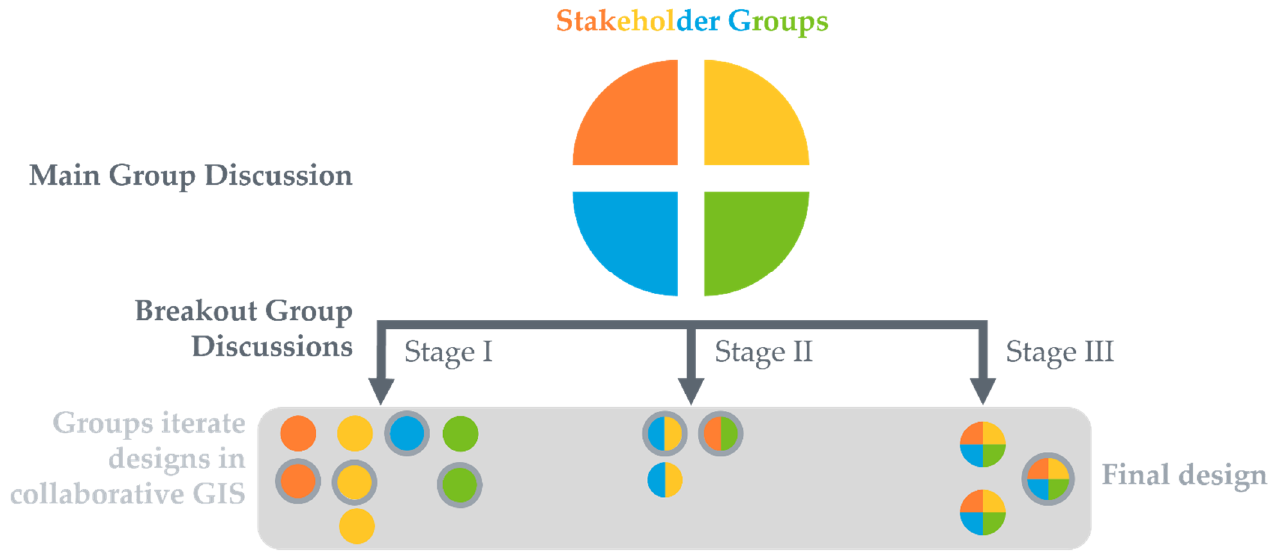
Figure 3. This schematic exemplifies the geodesign workshop structure. Stakeholder groups collaboratively generate one or more design iterations and select one to present to the main group. In successive stages, stakeholder groups increasingly work together to achieve a final design.